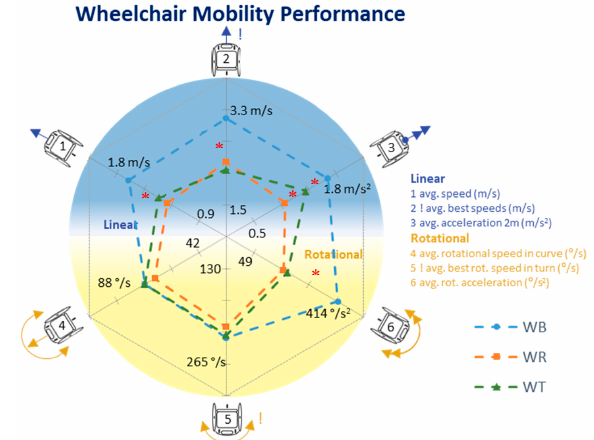
Figure 3. WMP for all sports for “high-class” athletes only. Significant (p < 0.05) differences are marked with a *. See Table A1 for the values (Appendix).